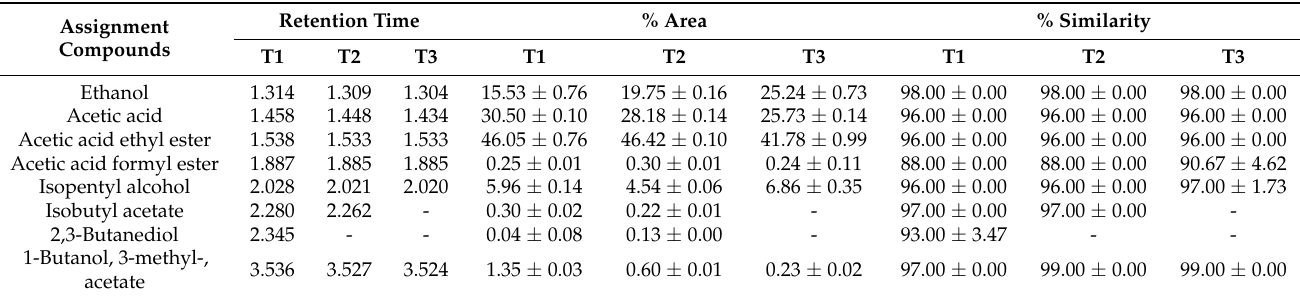
Table 4. Volatile compounds identified in pineapple vinegar samples using gas chromatography-mass spectrometer